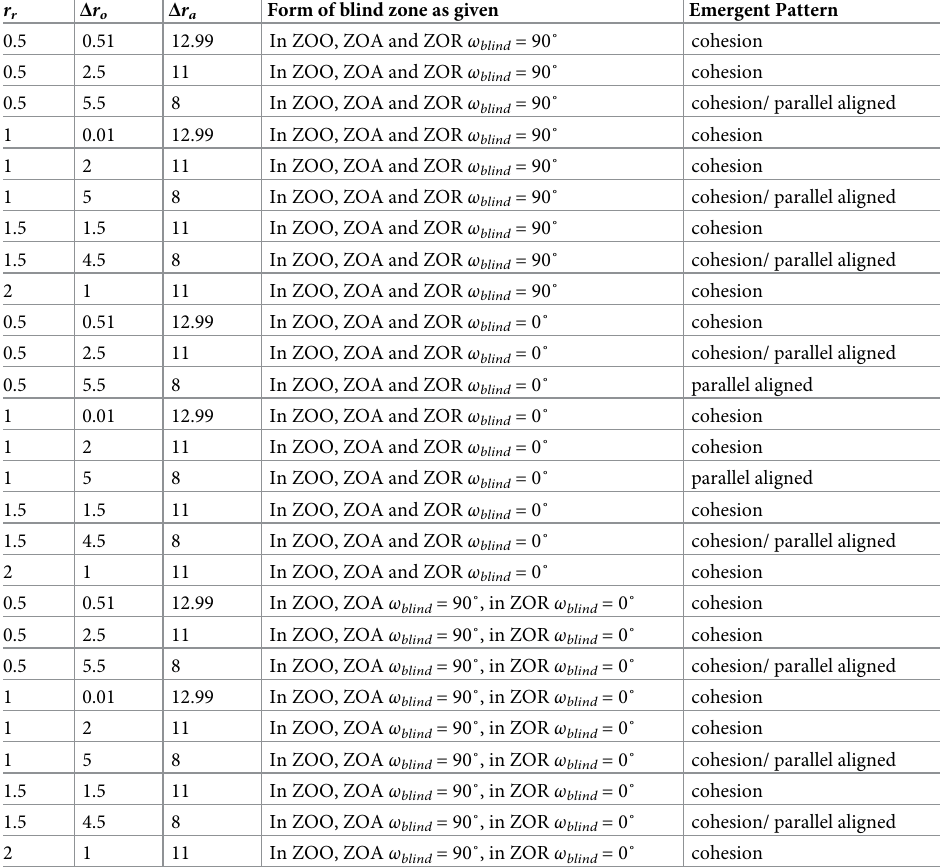
Table 2. Summary of zone size, size of blind region and respective emergent collective behaviour for simulations with 1000 time steps. r